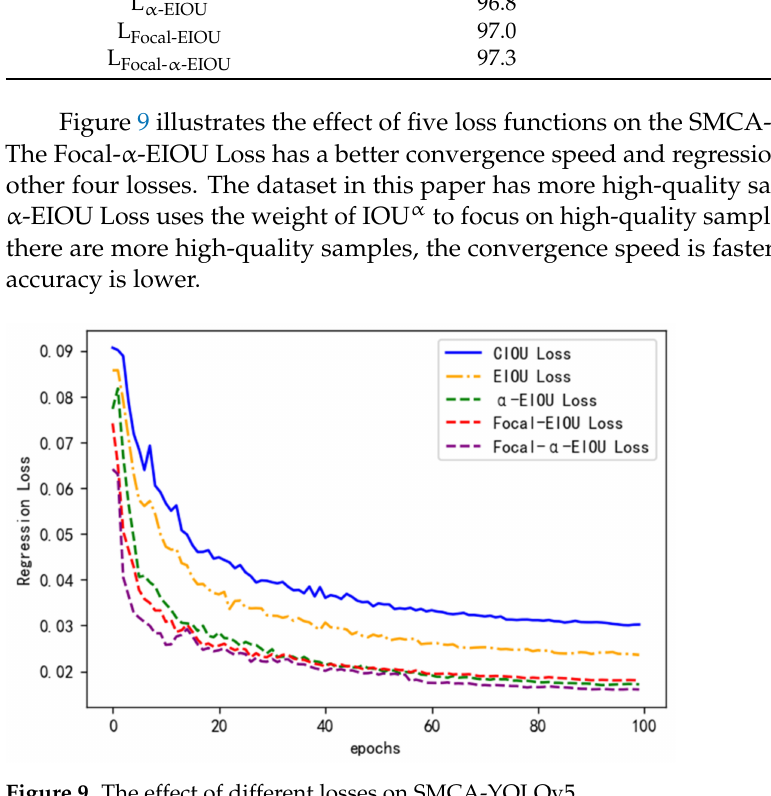
Figure 9. The effect of different losses on